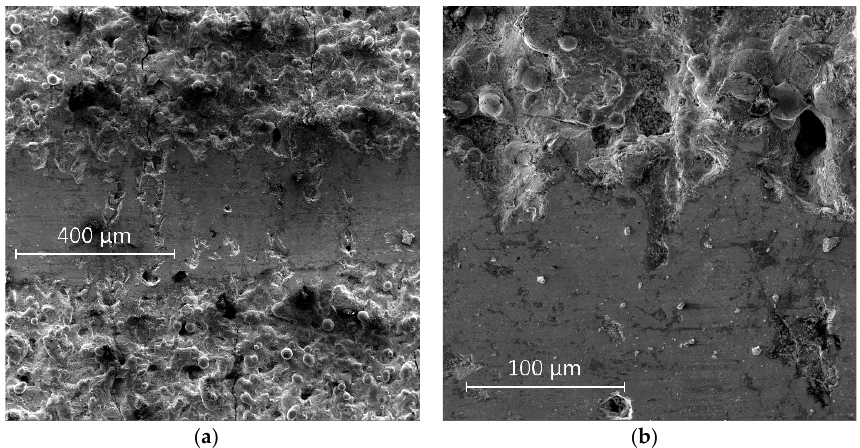
Figure 10. SEM of the wear track of the 50 Hz and 10 mm s −1 treated sample; ( a )200×, (b)750×.